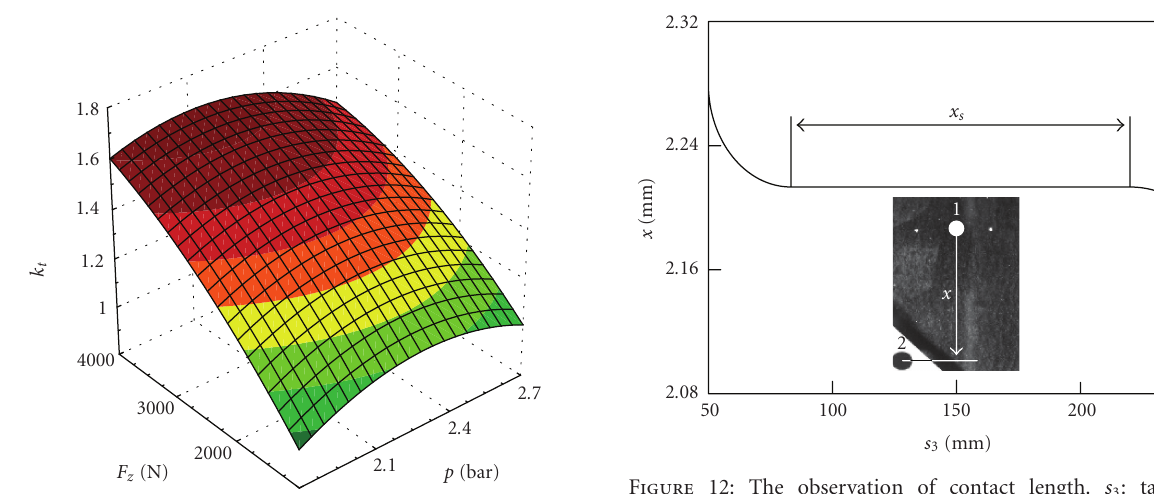
Figure 12: The observation of contact length. s 3 : tangential displacement of bearing plate (see Figure